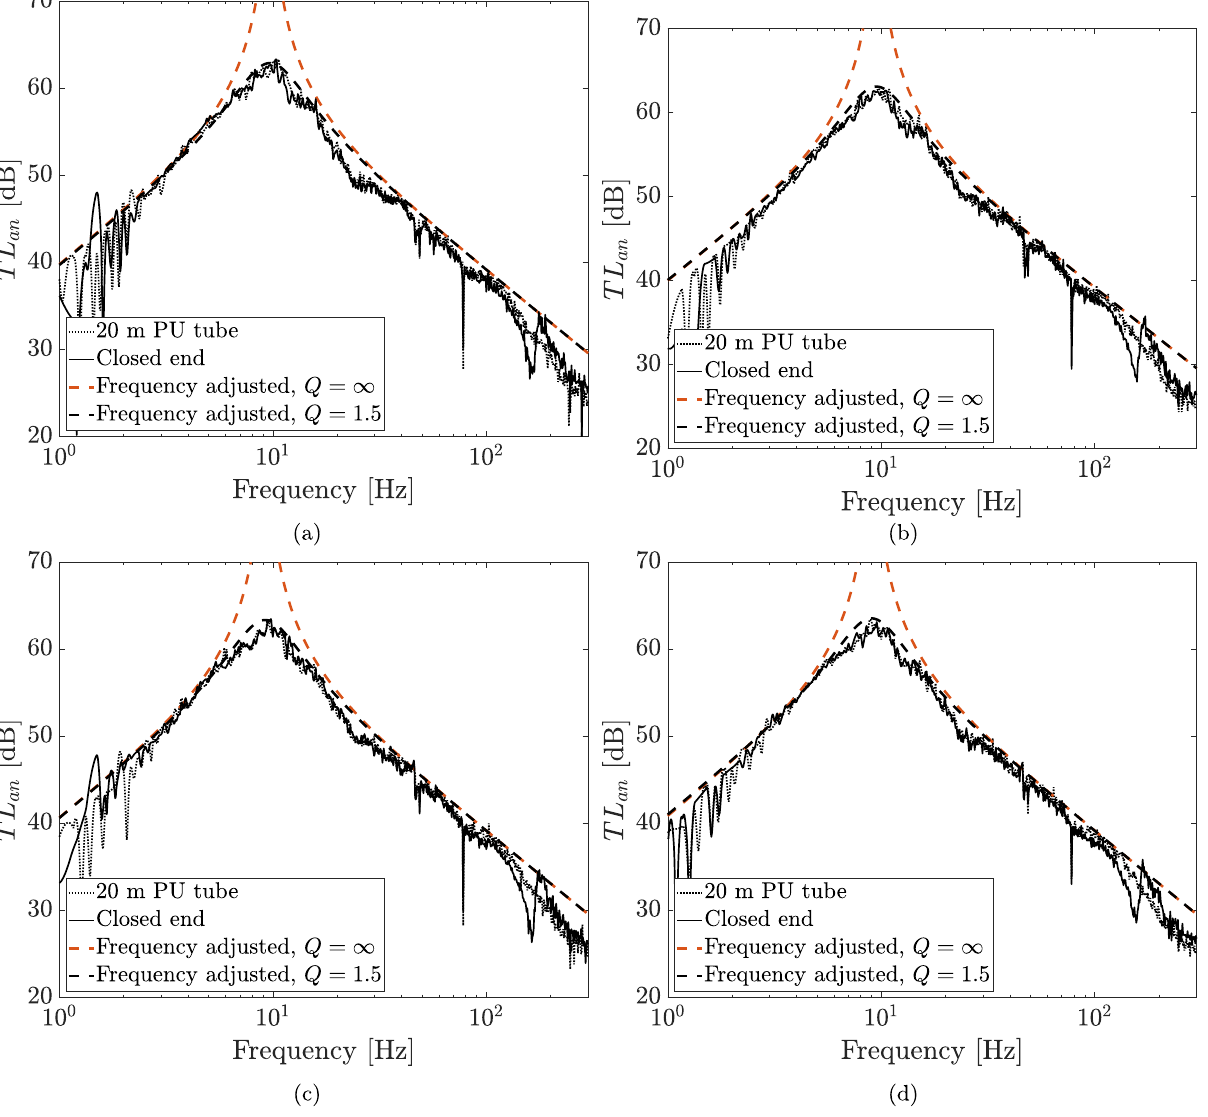
Figure 11. Comparison between measured, undamped frequency adjusted and damped ( Q = 1.5) frequency adjusted TL an plots of the gas resonator for a 20 m long PU-tube termination ( R B = (cid:1) 0.8) and a closed termination ( R B = 1). The transmission losses were calculated using multi-microphone method with robust-formulation.The resonance frequencies are fi ne tuned by varying the gas volume within the resonator cavity. (a) p 0 = 2.75 bar and p f = 5.0 bar; (b) p 0 = 3.0 bar and p f = 5.5 bar; (a) p 0 = 3.25 bar and p f